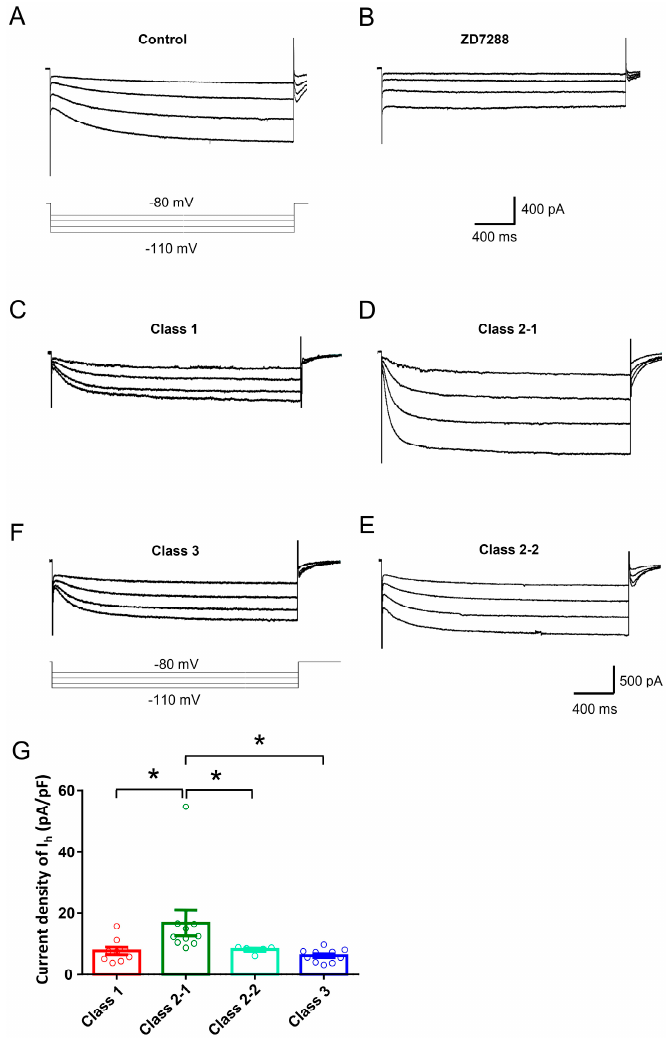
Figure 4. ( A , B ) Representative traces of I h recorded in large DRG neurons in response to hyperpolarizing voltage steps of − 60 to − 120 mV from a holding potential at − 60 mV ( A ) and its blockade by ZD7288 (15 µM); ( C – F ) Representative traces of I h recorded in different classes of large DRG neurons; ( G ) Analyses of current density of I h revealed that the magnitude of I h in Class 2-1 neurons was much higher than that in Class 1, 3 and 2-2 neurons ( n = 5–11, Uncorrected Fisher’s LSD one-way ANOVA, F(3,31) = 3.869, p = 0.0185, and in multiple comparisons * p = 0.0151 for Class 2-1